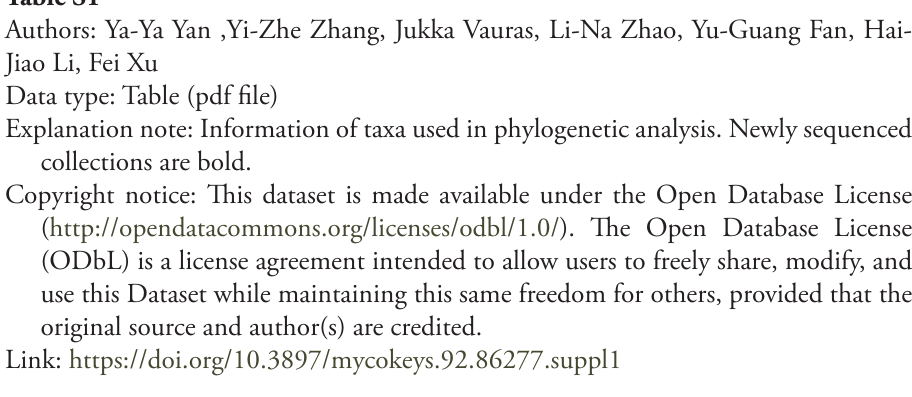
Authors: Ya-Ya Yan ,Yi-Zhe Zhang, Jukka Vauras, Li-Na Zhao, Yu-Guang Fan,